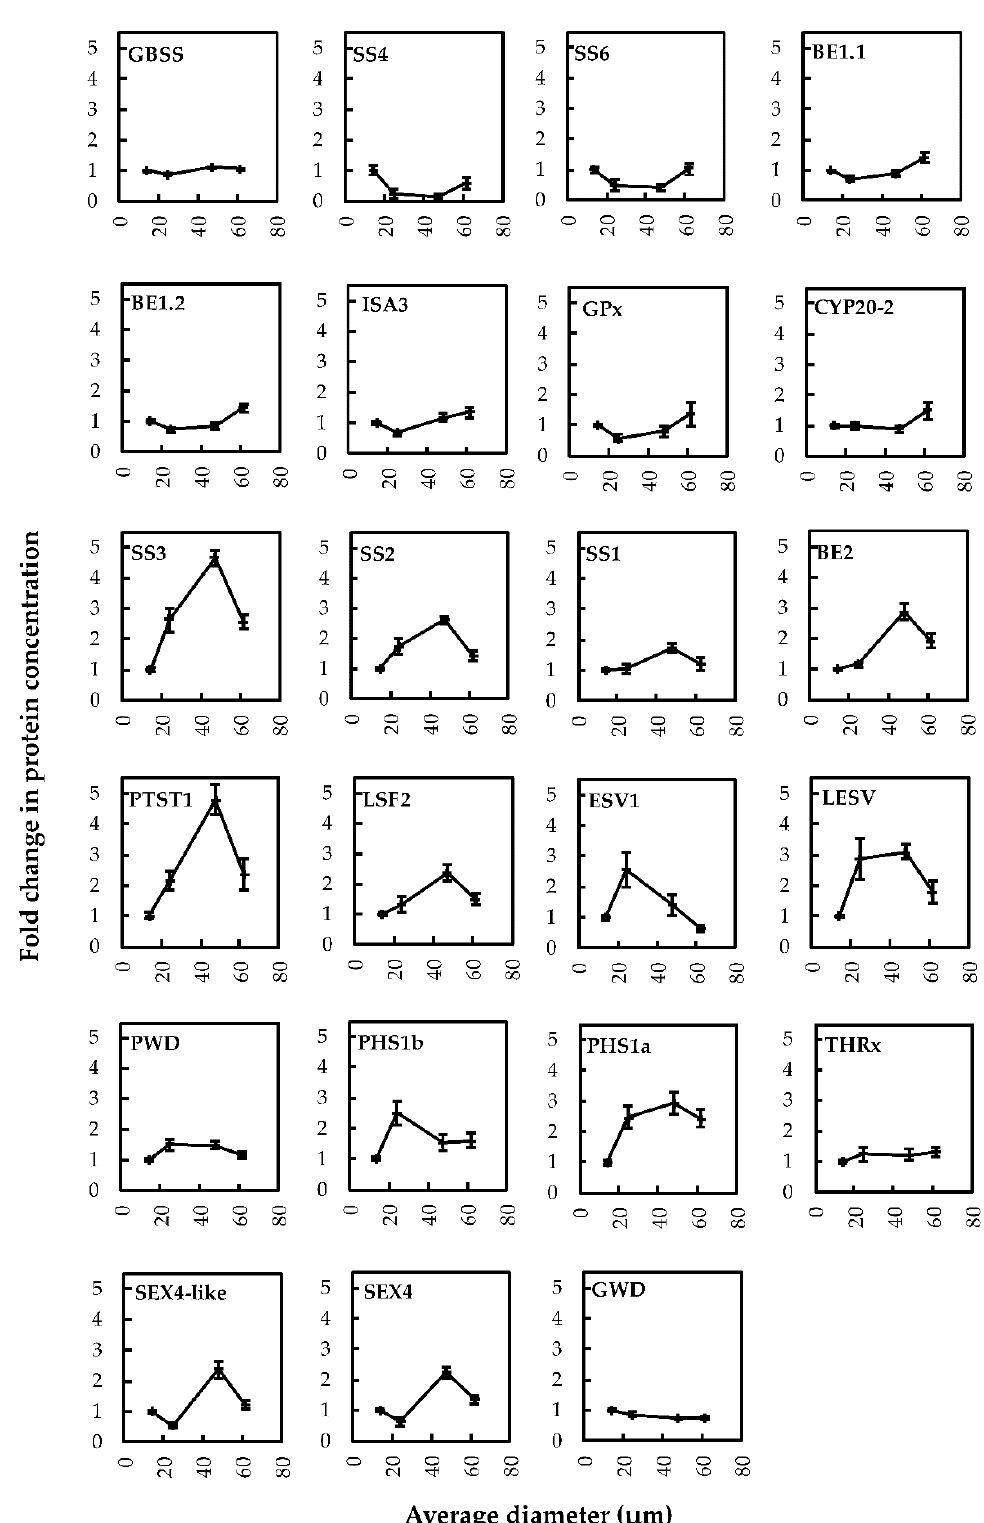
Figure 6. Fold changes in protein concentrations according to average granule diameter. Fold changes were calculated by normalizing the protein content in fraction A to 1. Error bars represent standard errors (SEs) calculated from three experimental replicates, with three technical replicates for each.